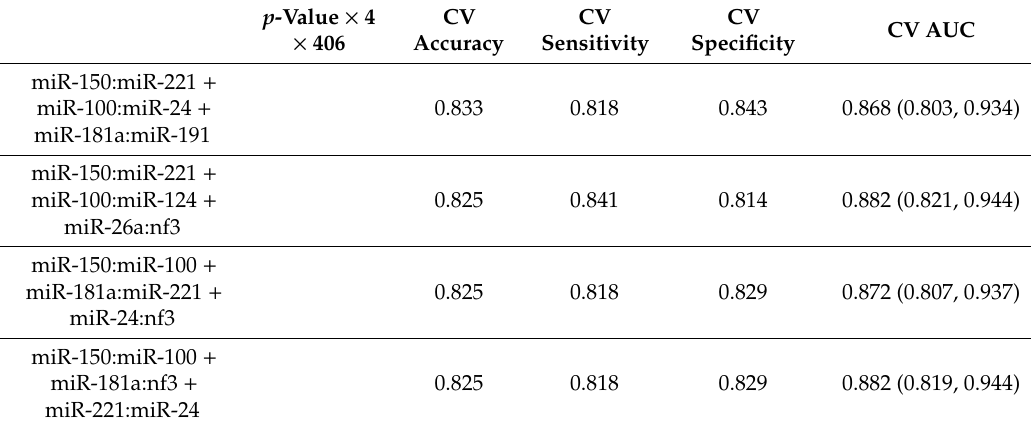
Table 4. Comparison of AML vs.